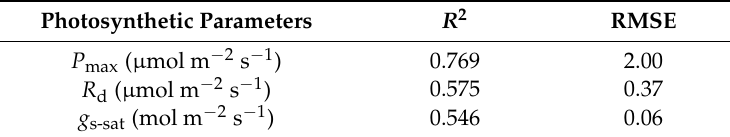
Table 3. Fitting statistics for simulations of P max , g s-sat and R d .